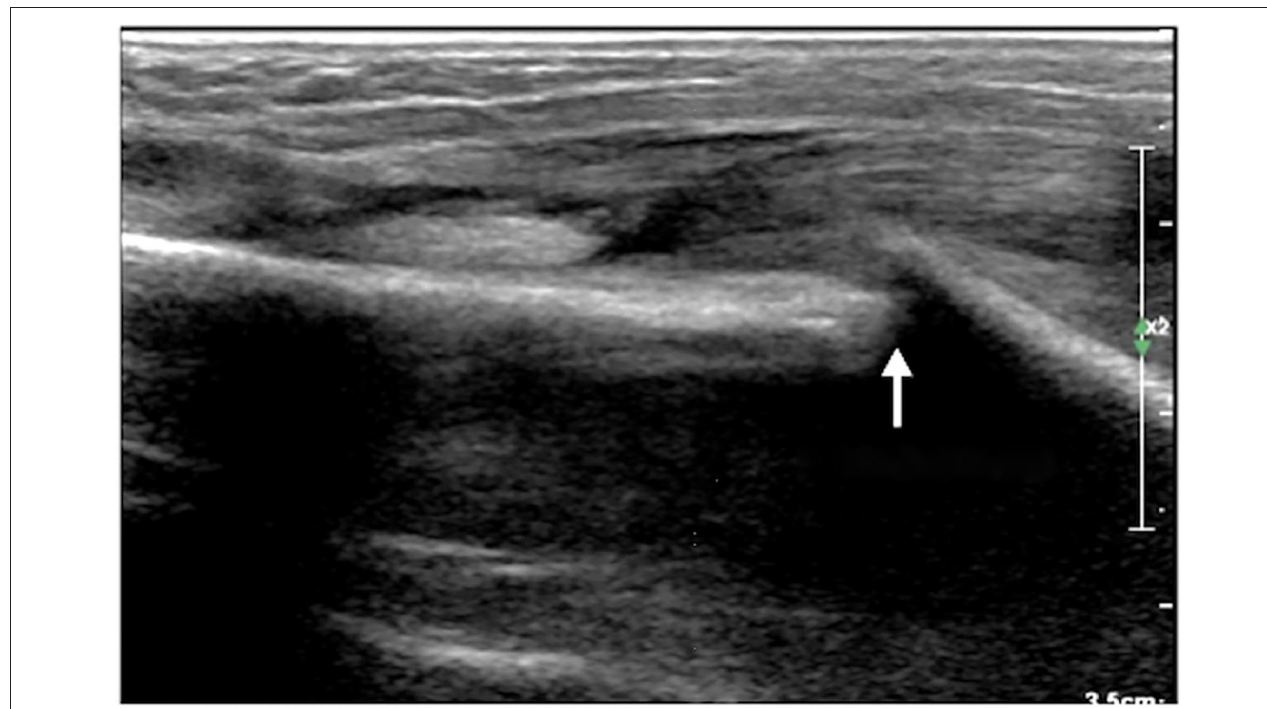
FIGURE 4 | Humeral fracture. The infant was G 2 P 1 with a gestational age of 39 + 2 weeks, forceps delivery, and birth weight of 4,000g. The patient was admitted to the hospital 20h after birth due to a 6-h fever. The diagnosis was intrauterine pneumonia. Physical examination revealed swelling, tenderness, limited mobility, and loss of the primitive reflex of the right upper limb; thus, the fracture was suspected. Ultrasound showed interrupted cortical continuity, visible broken ends, displacement, separation, and angulation of the right humerus.